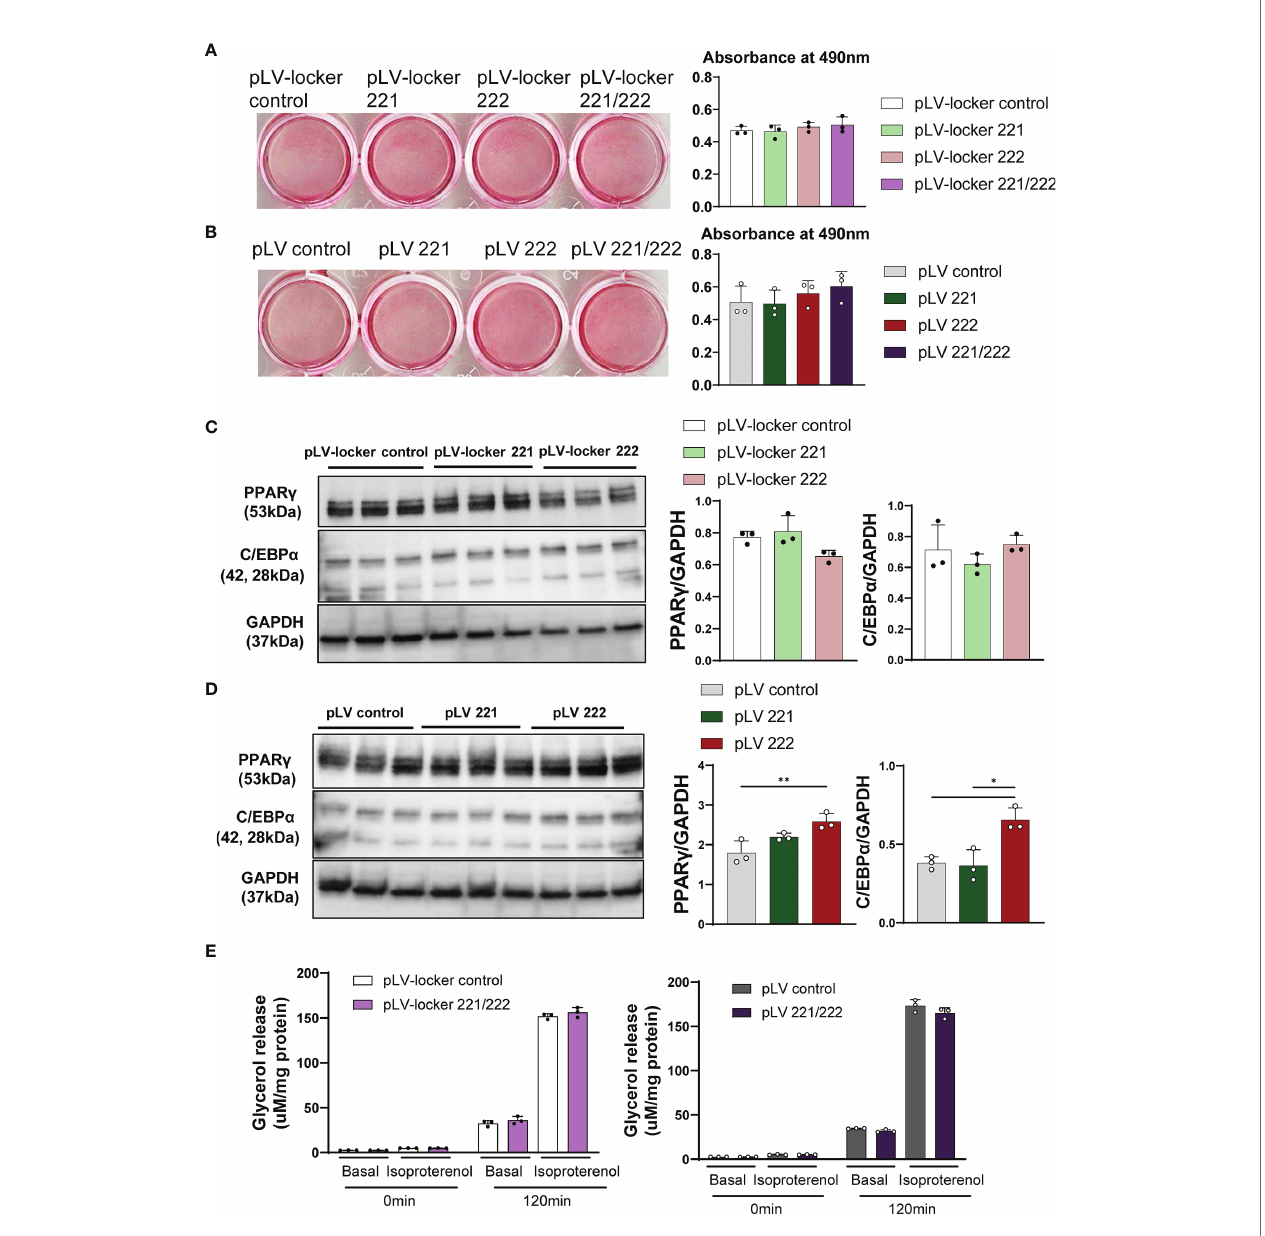
FIGURE 5 | Adipogenesis, lipogenesis and lipolysis in 3T3-L1 cells. Lentiviral vectors were transduced to 3T3-L1 cells at 2 days before the induction of differentiation and cultured for 7 days. (A) Oil-red O staining of differentiated 3T3-L1 cells treated with pLV-locker control, pLV-locker 221, pLV-locker 222, and pLV-locker 221/222. (B) Oil-red O staining of differentiated 3T3-L1 cells treated with pVL control, pLV 221, pLV 222, and pLV221/222. (C) Western blot analysis of PPAR g in differentiated 3T3-L1 cells treated with pLV-locker control, pLV-locker 221, pLV-locker 222, and pLV-locker 221/222. (D) Western blot analysis of PPAR g in differentiated 3T3-L1 cells treated with pVL control, pLV 221, pLV 222, and pLV221/222. (E) Lipolysis assay in 3T3-L1 cells stimulated with isoproterenol. Differentiated 3T3-L1 cells were treated with pLV-locker 221/222 and pLV 221/222. Data shown as mean ± SD and analyzed by one-way ANOVA with Tukey test (*p<0.05;